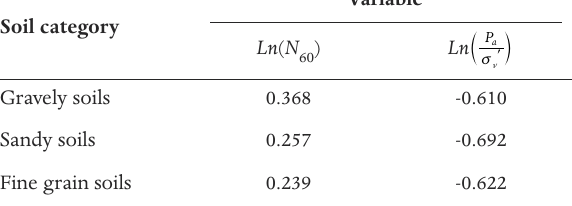
Table 4. Standardized correlation coefficients of N